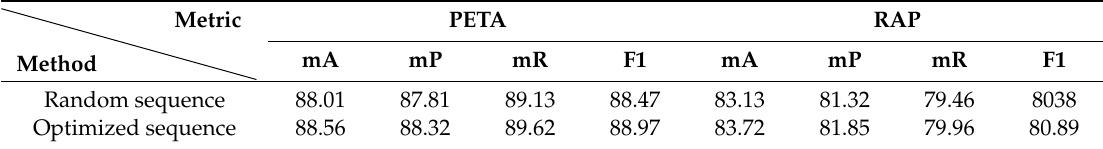
Table 3. Experimental results on the e ff ect of the optimized prediction